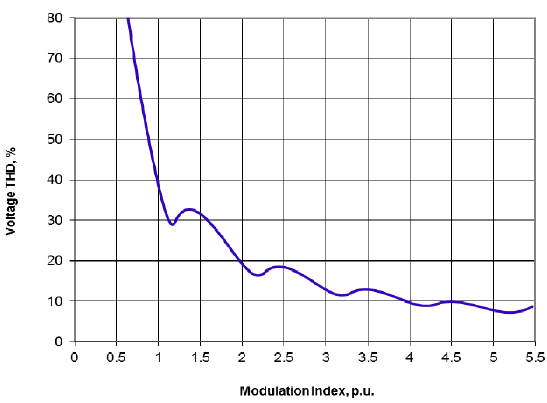
Figure 2. Minimal voltage total harmonic distortion ( THD ) for n = 5 (up to 11 voltage levels).